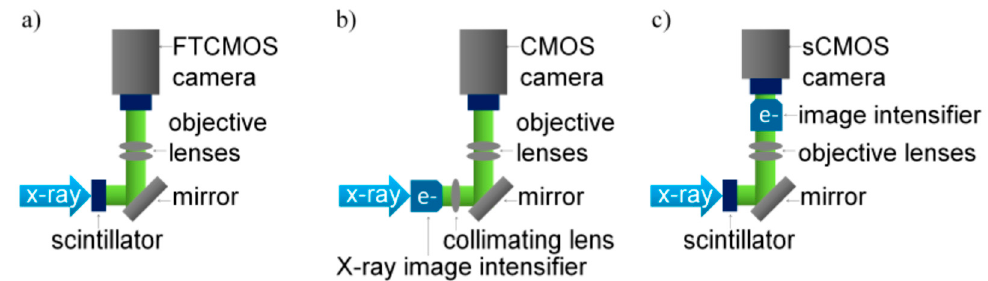
Figure 4. Reproduction of Figure 1 of Olbinado et al. [64], showing simplified schematics of X-ray imaging techniques. ( a ) MFPS frame rate, propagation based XPCI; ( b ) kFPS frame rate di ff raction topography; ( c ) single-bunch, single grating interferometry and speck based XPCI at ID19. © IOP Publishing Ltd and Sissa Medialab. Reproduced with permission of IOP Publishing. All rights